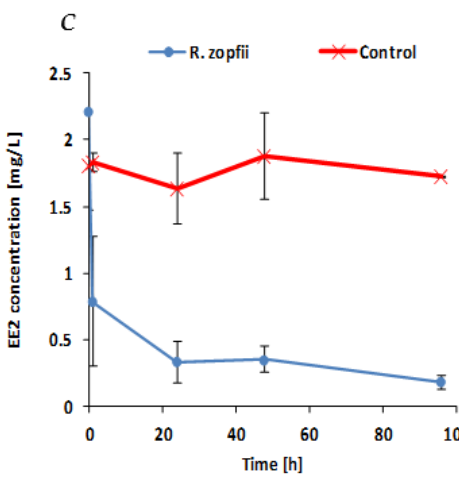
Figure 2. ( A ) EE2 biodegradation in minimal salt medium (MSM) medium supplemented with